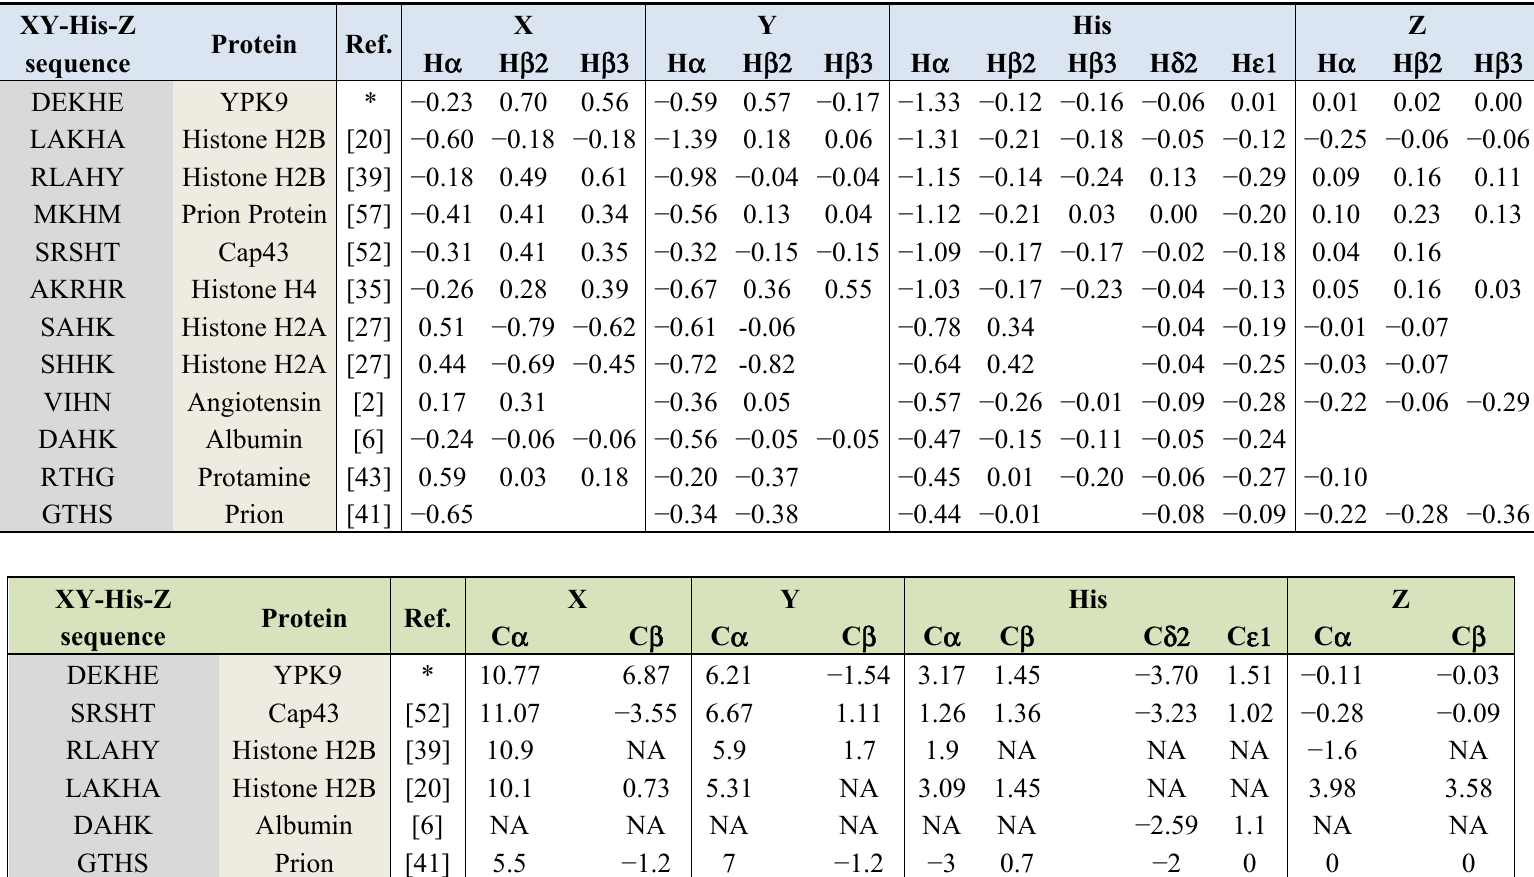
Table 2. 1 H- and 13 C-NMR chemical shift variations ( Δδ = δ coordination mode.